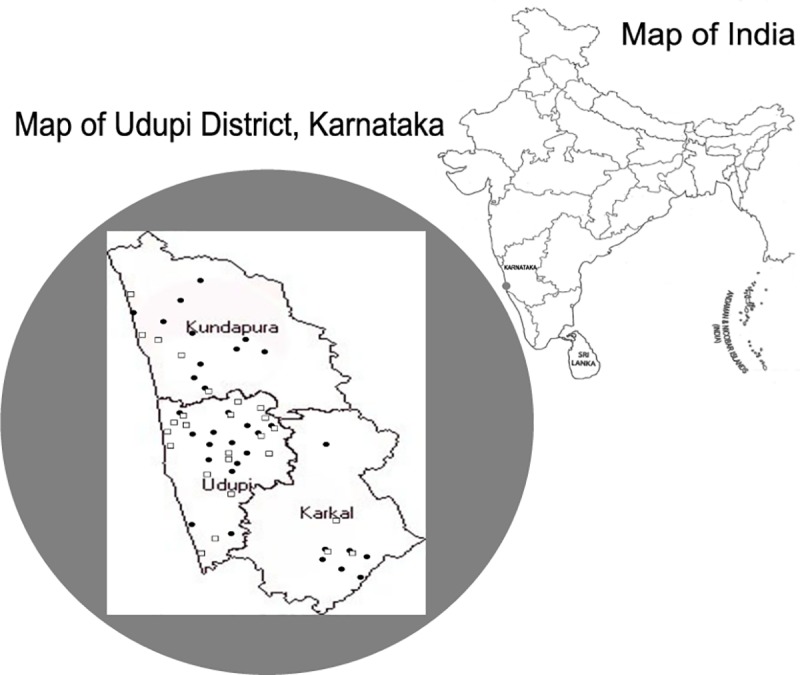
Location of screening camps.Map illustrating the geographical location of the screening camps across three regions of Udupi district of southern coastal Karnataka, India, which has an area of 3880 square kilometres. Black dots represent the camps organised for tribal population and unfilled squares represent the camps organised for general population.